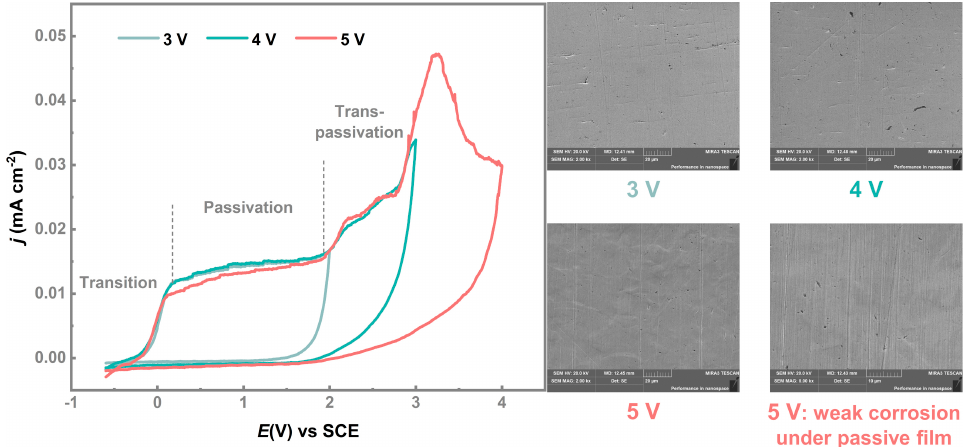
Figure 5. Cyclic voltammetry curves and SEM observations on anodic Hf corrosion in the Et 4 NHSO 4 -based anhydrous ethanol system. Condition: on Hf in the ethanol and acetonitrile ( V / V = 1:1) solution containing 0.06 M Et 4 NHSO 4 at different potentials, 30 °C and a scanning rate of 1 mV/s; SEM images were obtained by chronoamperometry at different potentials for 100 s.